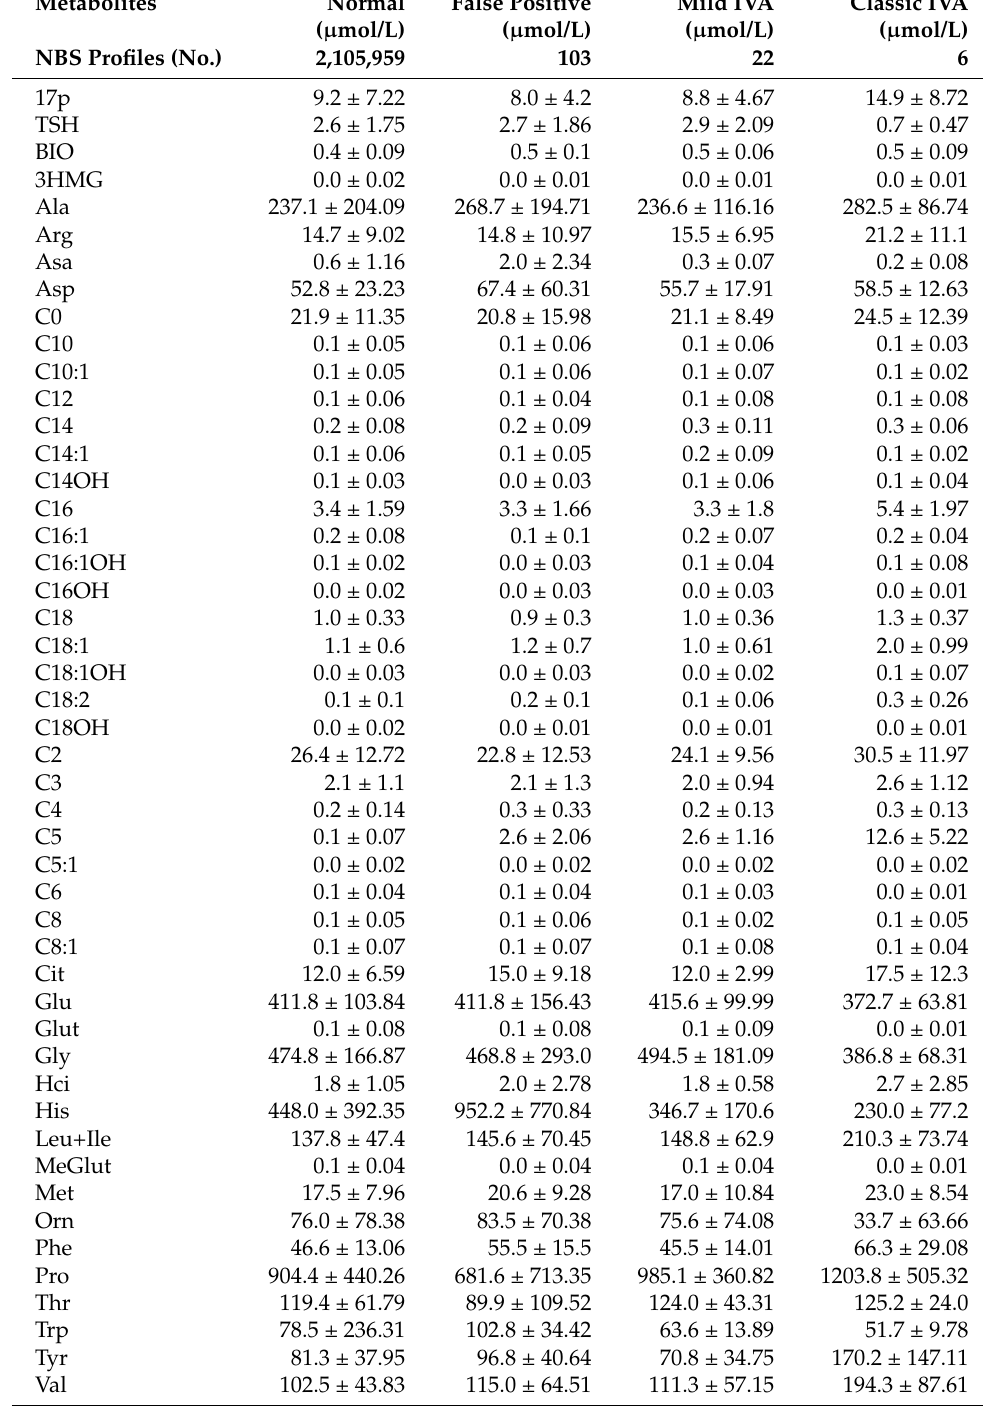
Table 1. Mean values and standard deviation of 48 metabolite concentrations measured in dried blood samples ( µ mol/L) for the groups of normal and false positive NBS profiles as well as newborns with mild and classic IVA. The abbreviations can be found in Supplementary Table